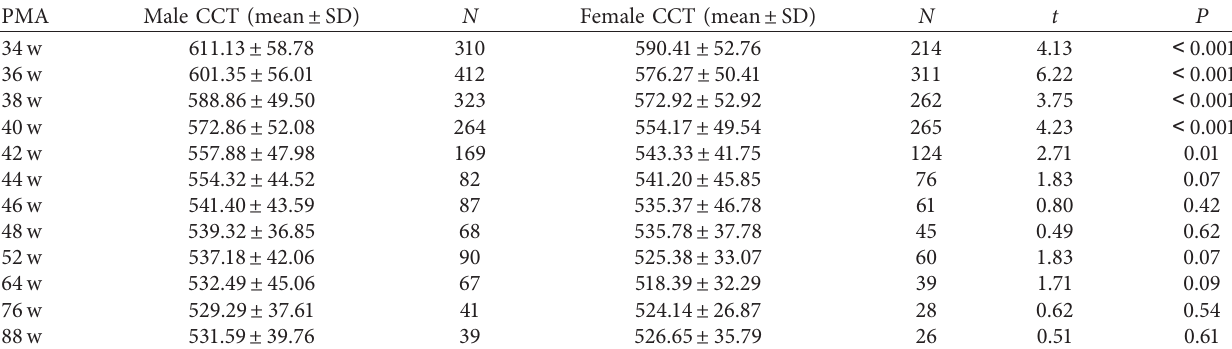
Table 3: Mean CCT of different genders at each PMA.